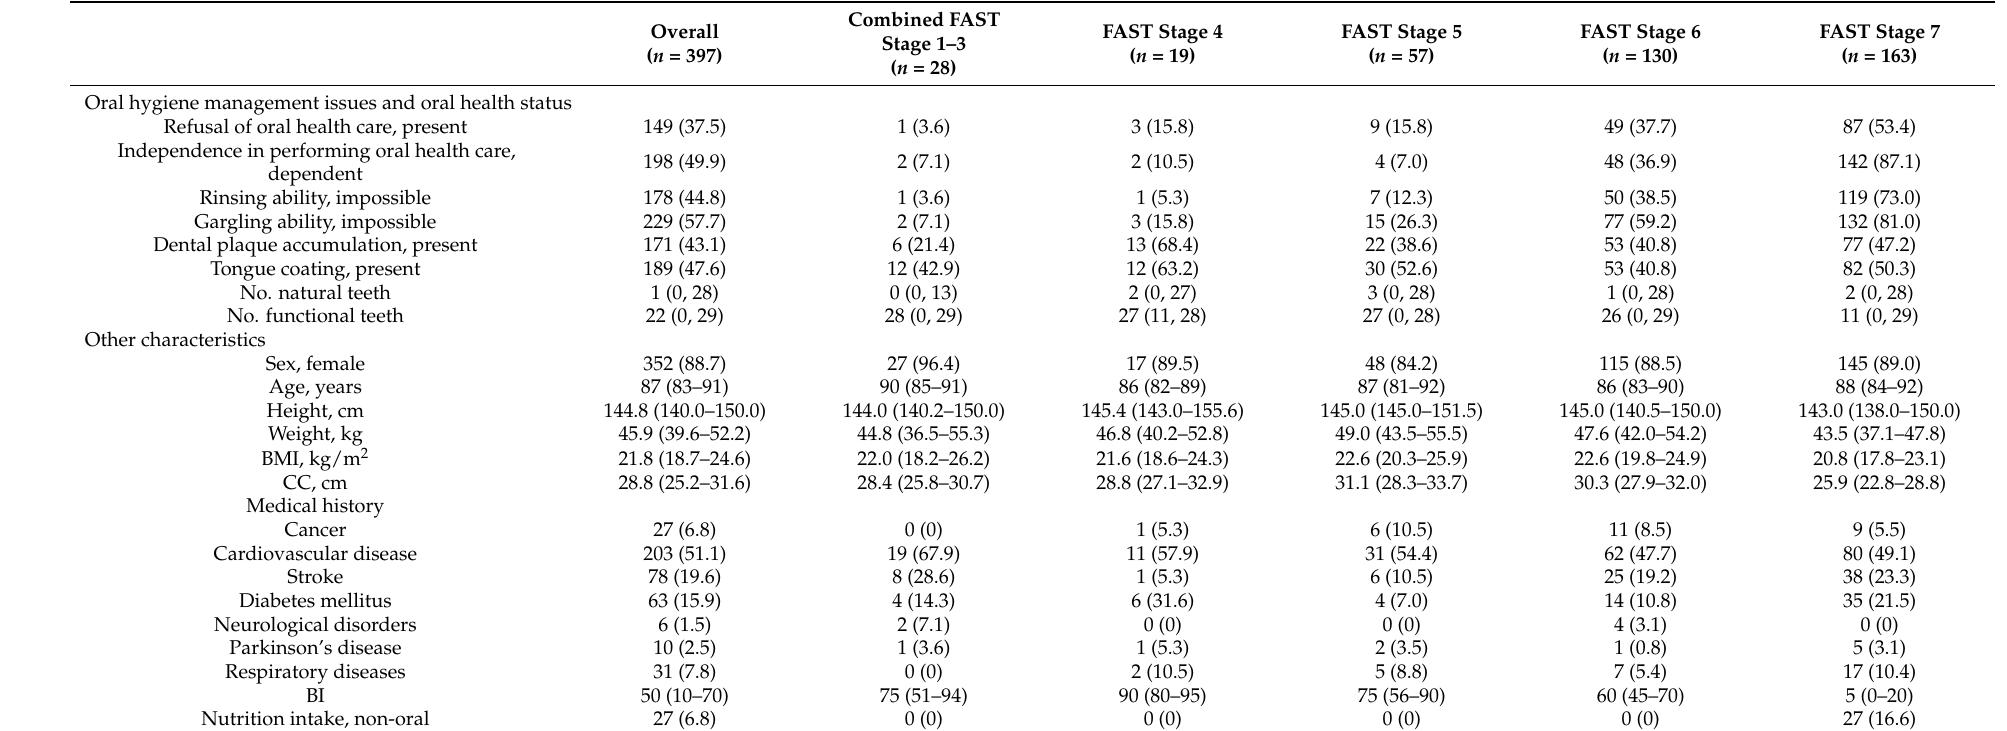
Table 1. Case characteristics according to